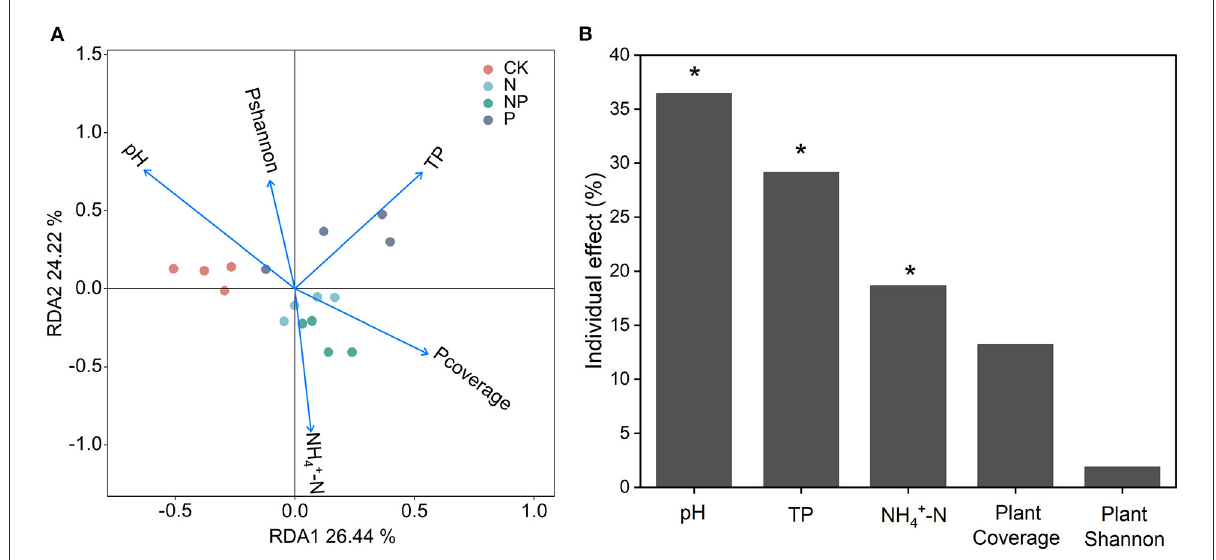
FIGURE4 (A) Soil bacterial community composition and its variation partition ordination plot of a redundancy analysis (RDA) under N and P additions treatments. (B) The black bars for the independent explanation of bacterial community composition calculated by hierarchical partitioning. (The percentage of values shows adjusted R 2 , *indicates P < 0.05). TP, total phosphorus; NH + 4 -N, ammonium nitrogen; Pcoverage, plant coverage and Pshannon, plant Shannon. Proportions for the bacterial community composition were explained by soil properties and plant parameters.